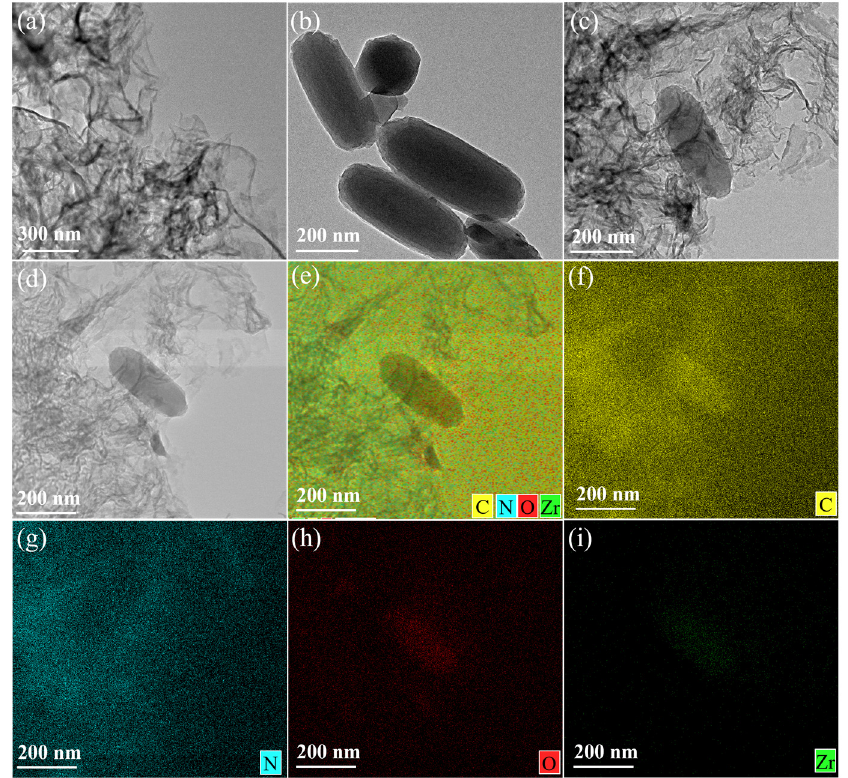
Figure 2. TEM images of ( a ) 2D CNs, ( b ) PCN-222 and ( c ) PCN-222/CNs. ( d – i ) TEM-EDS elemental mapping of PCN-222/CNs.